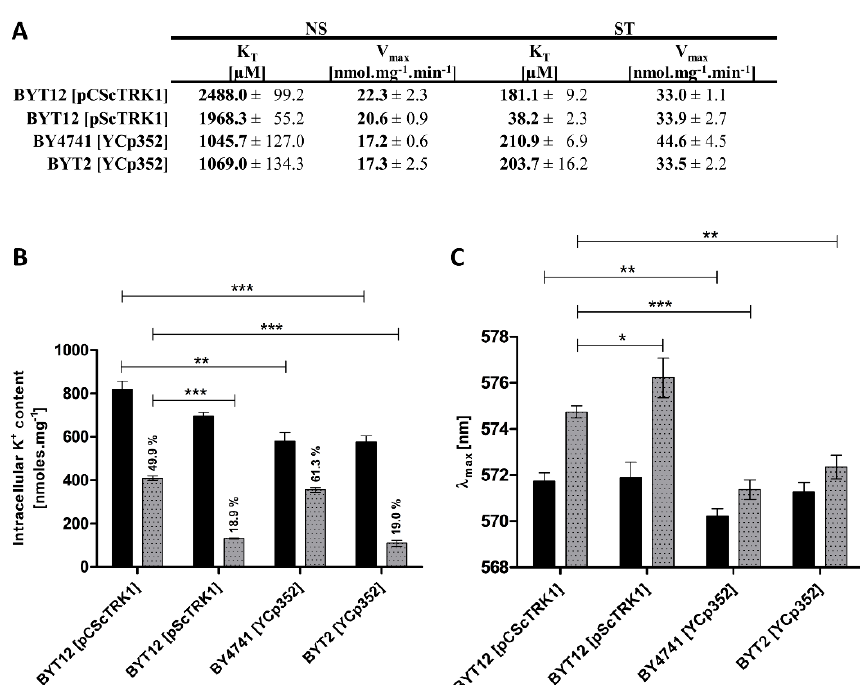
Figure 3. Differences in kinetic parameters, intracellular K + content and membrane potential among strains. Cells expressing TRK1 either from chromosome (BY4741[YCp352] and BYT2 ( trk2 ∆ )[YCp352]) or from centromeric (BYT12[pCScTRK1]) and multicopy plasmids (BYT12[pScTRK1]), respectively, were grown as described in Section 2, and used directly (non-starved (NS) cells) or first incubated in a YNB-F (15 µ M K + , conditions of potassium starvation) for 1 h (starved (ST) cells). ( A ) Differences in kinetic parameters of Rb + uptake. Initial uptake rates and kinetic parameters were estimated as in Figure 1B. ( B ) Intracellular K + content. Three aliquots of NS (black columns) or ST (grey columns) cell suspension were withdrawn and the concentration of K + in cells was estimated as described in Section 2. ( C ) Relative membrane potential. The membrane-potential measurement was performed as in Figure 1G with NS (black columns) and ST (grey columns) cells. The λ max reached after 50 min of staining is shown for each strain. Significant differences in ( B , C ) are indicated with asterisks (* p < 0.05; ** p < 0.01; *** p < 0.001).